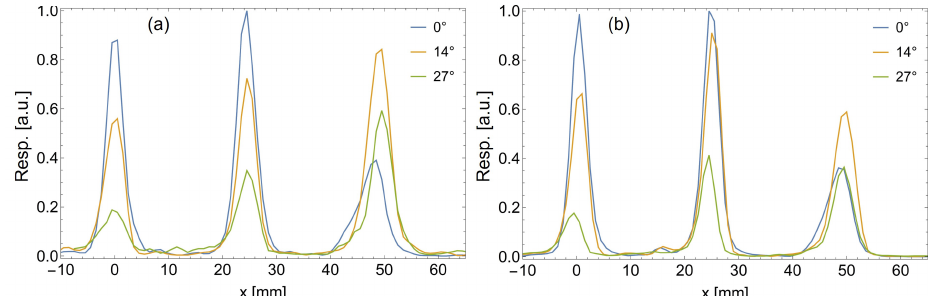
Figure 9. Cross sections along the spots measured in the focal plane of the f = 100 mm and ν = 150 GHz structure with ( a ) QOD and ( b ) WR51 detectors. Blue, orange and green lines denote the configurations with the detectors placed at an angle of 0 ◦ , 14 ◦ and 27 ◦ , respectively. These geometries reflect the situations in which the detectors face the center of the lens from the positions of M, L and 2L focal spots.